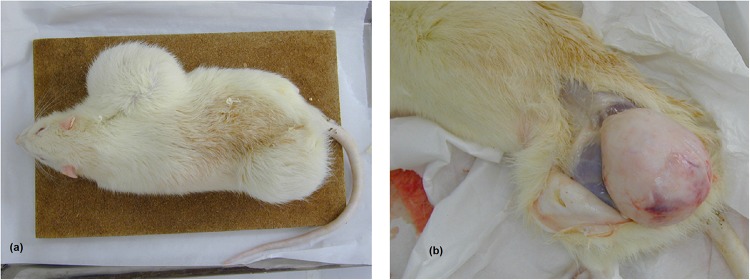
(a) Picture of one exposed rat with two fibromas (left)–(b) macroscopic view of the femoral tumour (right).The two fibromas were in the axillary and the femoral area, the macroscopic view was taken at autopsy (death at 18.5 months).